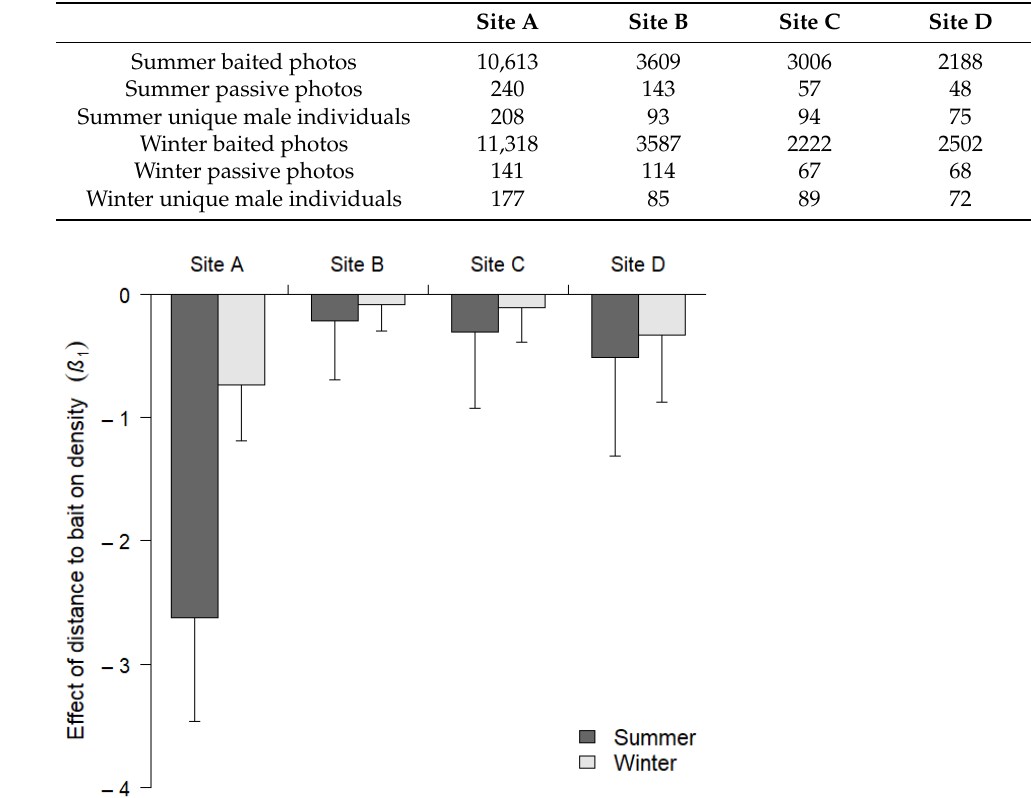
Figure 3. The effect of distance to bait on adult male white-tailed deer ( Odocoileus virginianus ) density distributions within four sites during summer 2015 and winter 2016 surveys in southwestern Georgia, USA.